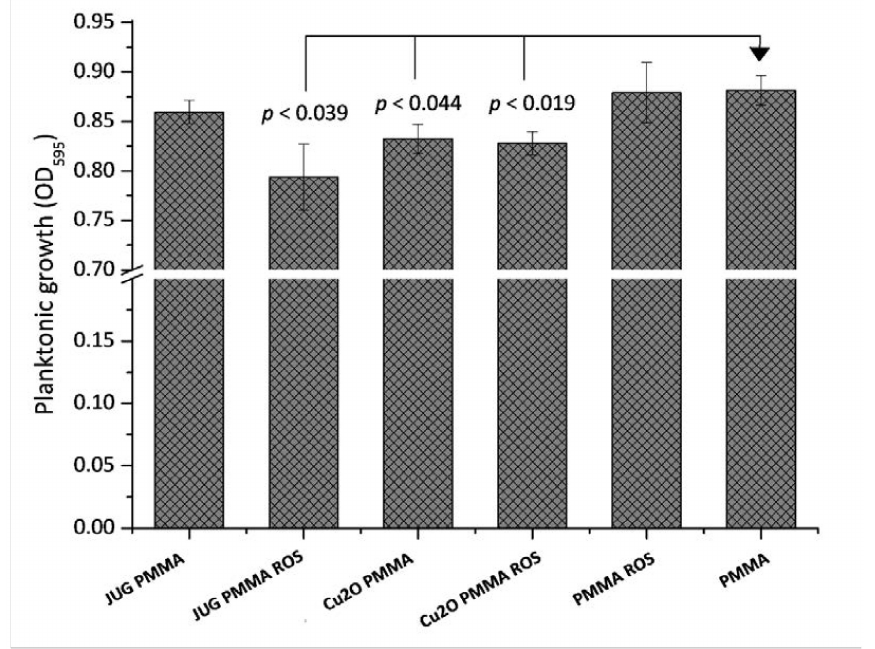
Figure 3. Planktonic growth of C. marina at the experimental end-point (48 h), taken from wells containing the coated surfaces as indicated in the x -axis. JUG = juglone, PMMA = poly(methyl methacrylate), ROS = rosin. Error bars ±